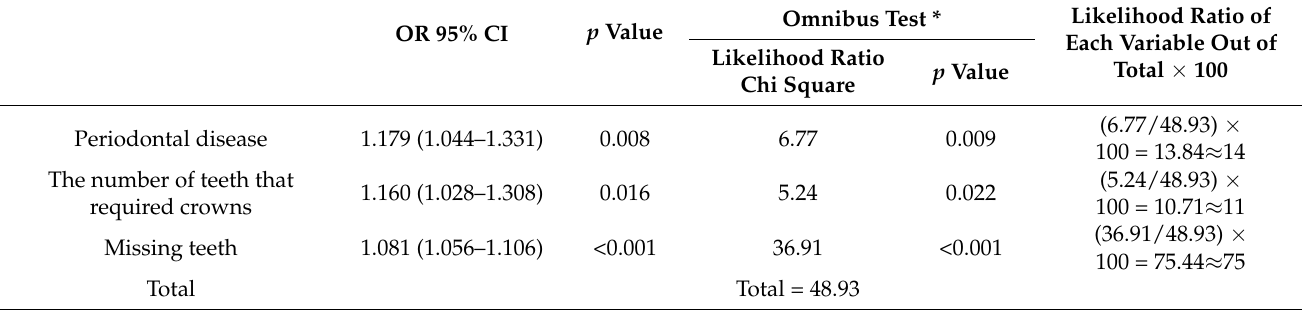
* Omnibus test—Compare the fitted model against the intercept-only model. CI: Confidence